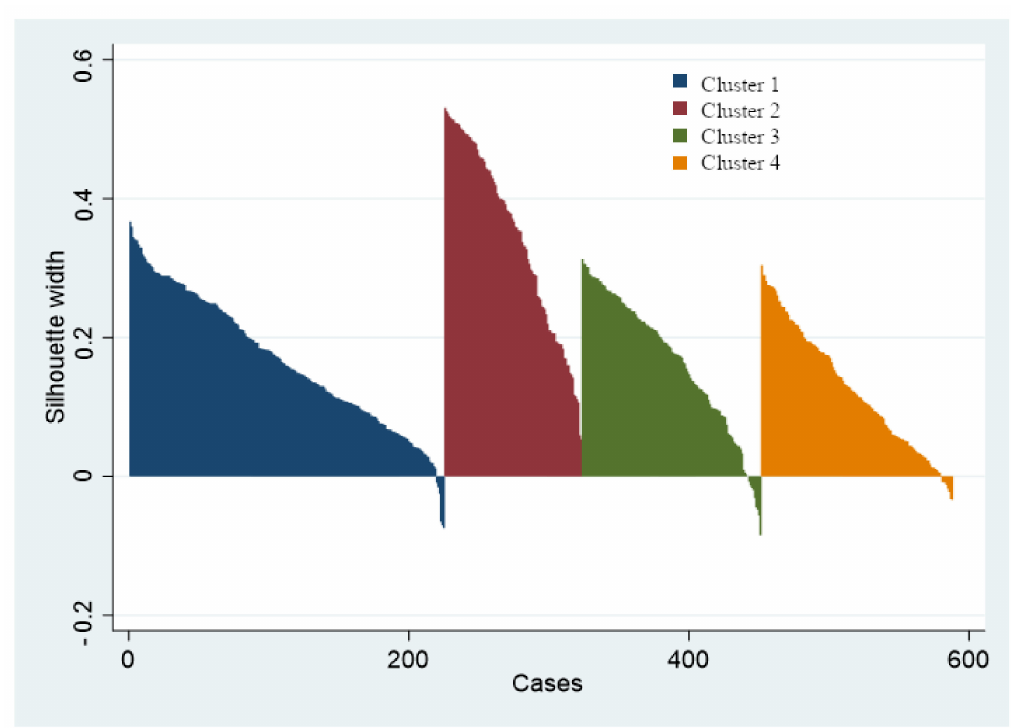
Figure A1. Silhouette results for the best cluster